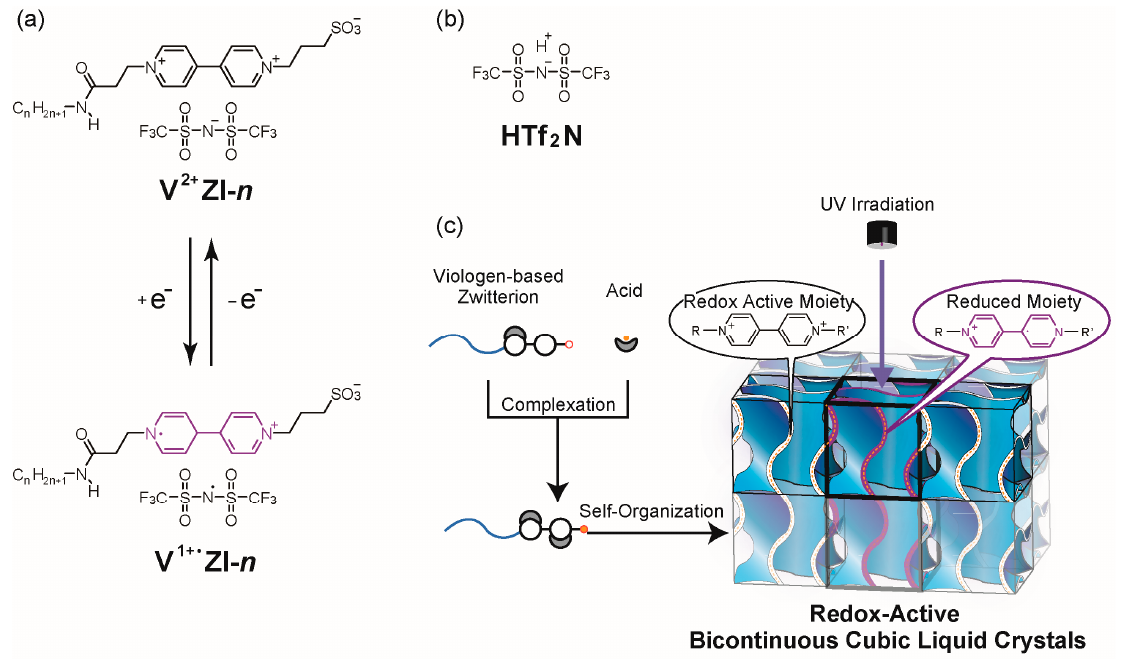
Figure 1. ( a ) Design of amphiphilic molecules with a viologen-based zwitterionic head group ( V 2+ ZI- n ) and their radical mono cation state ( V 1+ • ZI- n ); ( b ) Molecular structure of HTf 2 N ; ( c ) Equimolar mixing of V 2+ ZI- n and HTf 2 N forming redox-active bicontinuous cubic liquid-crystalline phases.